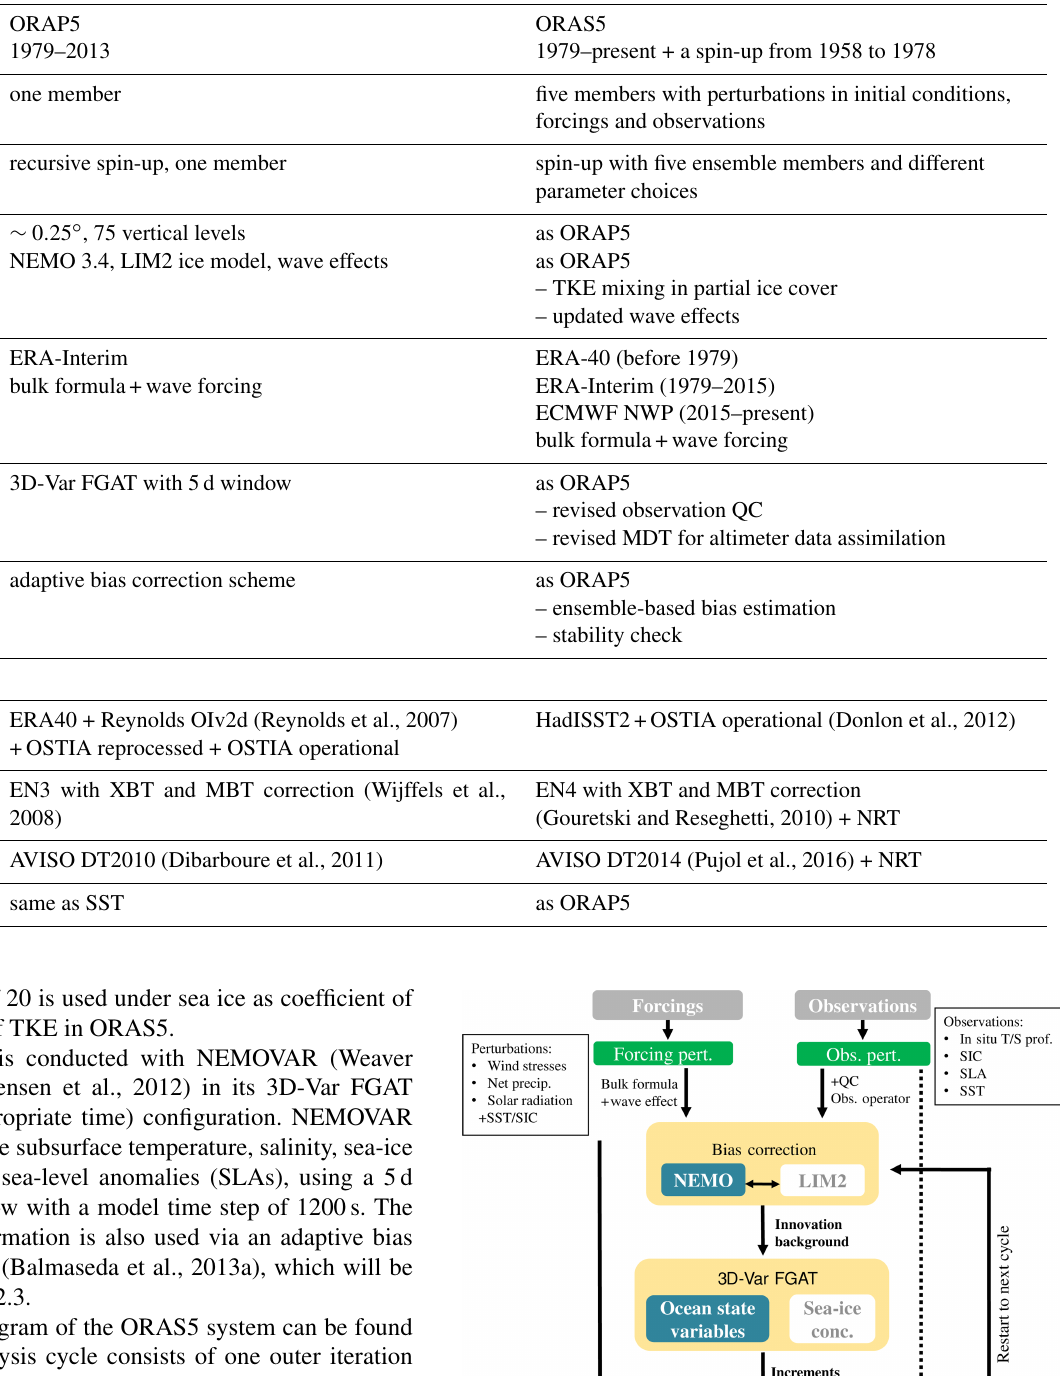
Table 1. Overview of differences between ORAP5 and ORAS5 in production system settings.